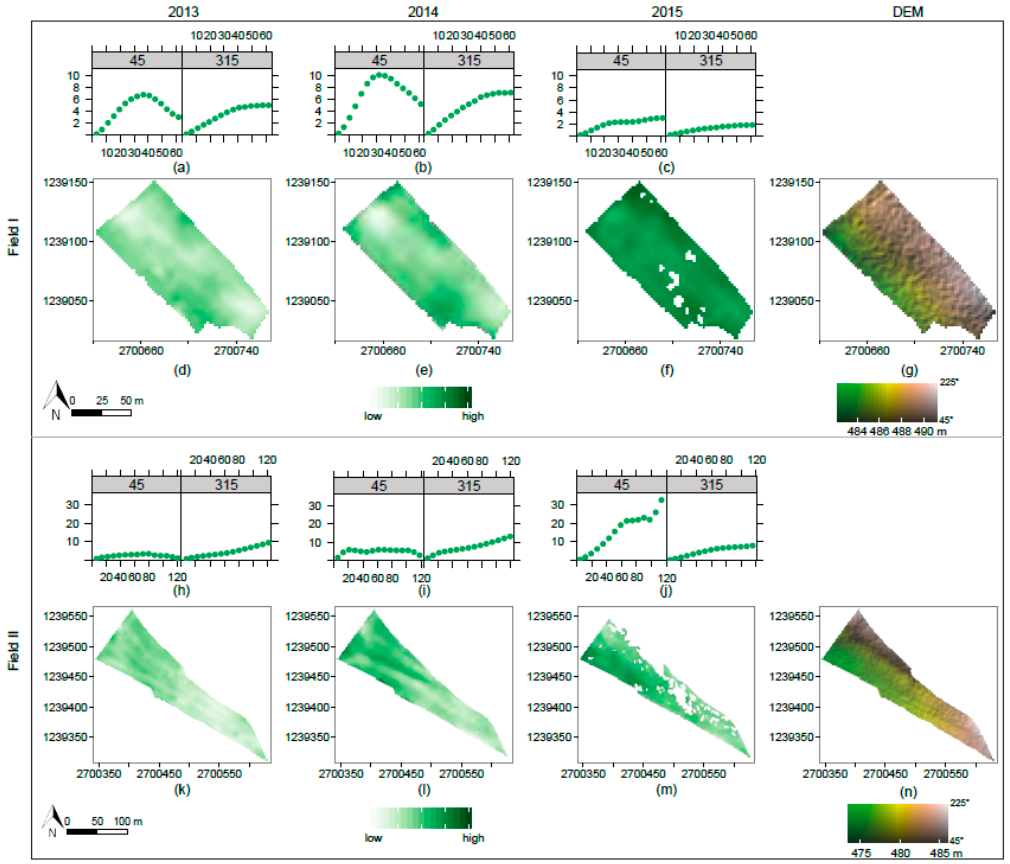
Figure 10. The first PC values ( d – f , k – m ); the corresponding 45° and 315° variograms ( a – c , h – j ); and the DEM (overlaid with a hillshade: 315° azimuth and 45° altitude) of two individual agricultural fields (Field I and Field II) for all three years (2013, 2014, and 2015) ( g , n ). The axes of the variograms have the distance (m) on the x-axis and the semi-variance on the y-axis.